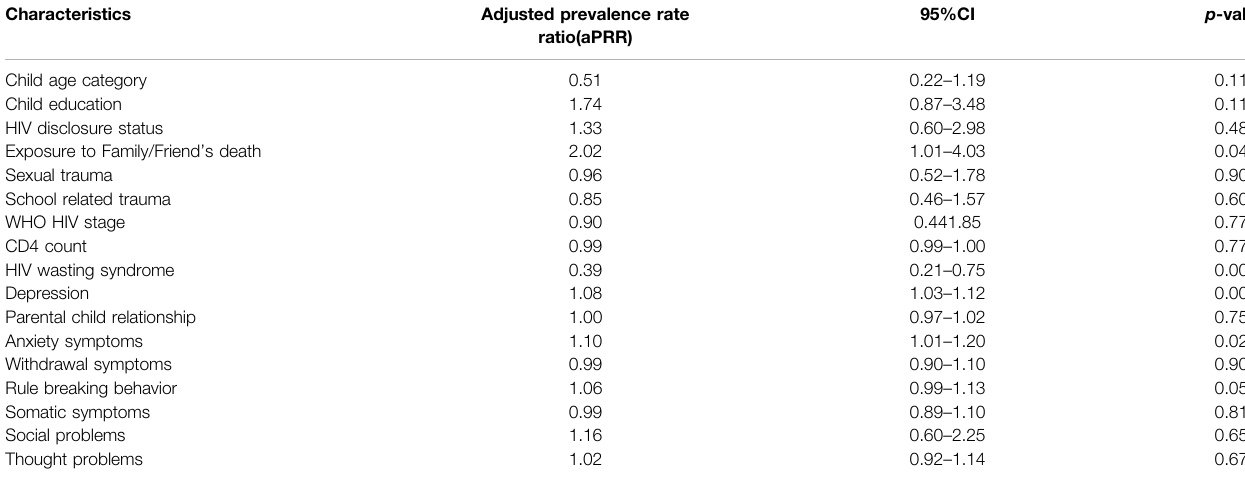
TABLE 4 | Multivariate logistic model. Independent Factors associated with Suicidal ideations among HIV infected Adolescent Children ( N (cid:1) 271).